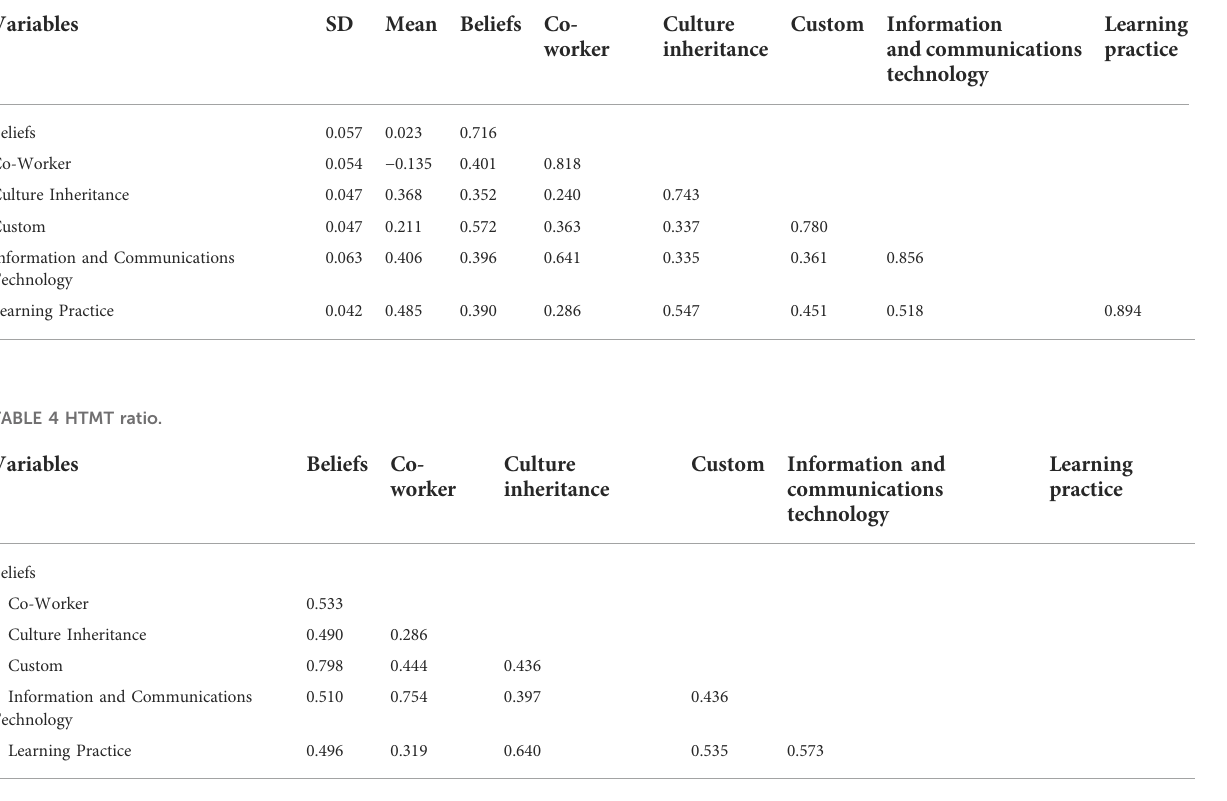
TABLE 3 Fornell-Larcker criterion.